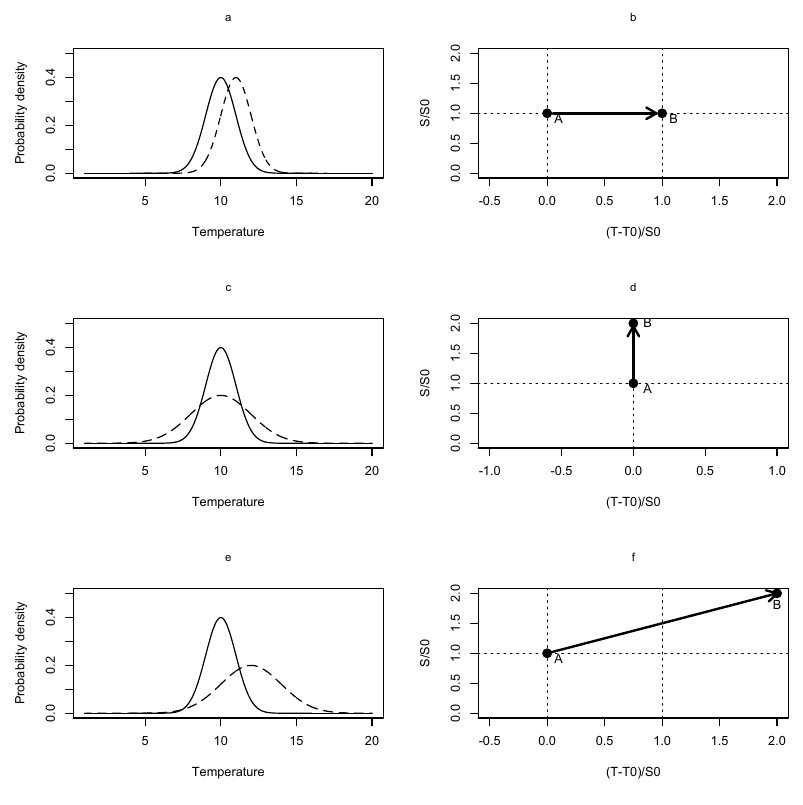
Fig. 1. Graphical representation of changes in the mean and standard deviation on a Gaussian climate distribution A with mean T 0 and standard deviation S 0 resulting in distribution B with mean T and standard deviation S . (a) Probability density functions (pdfs) where the mean from distribution A (continuous) changes to distribution B (dashed), (b) distributions A and B from (a) in a standardized MSC plot showing standardized changes in the mean ( T - T 0)/ S 0 against standardized standard deviation S / S 0, (c) pdfs where the standard deviation from distribution A changes to distribution B. (d) standardized MSC plot of (c) , (e) pdfs where both the mean and the standard deviation from A change to B, (f) standardized MSC plot of (e)